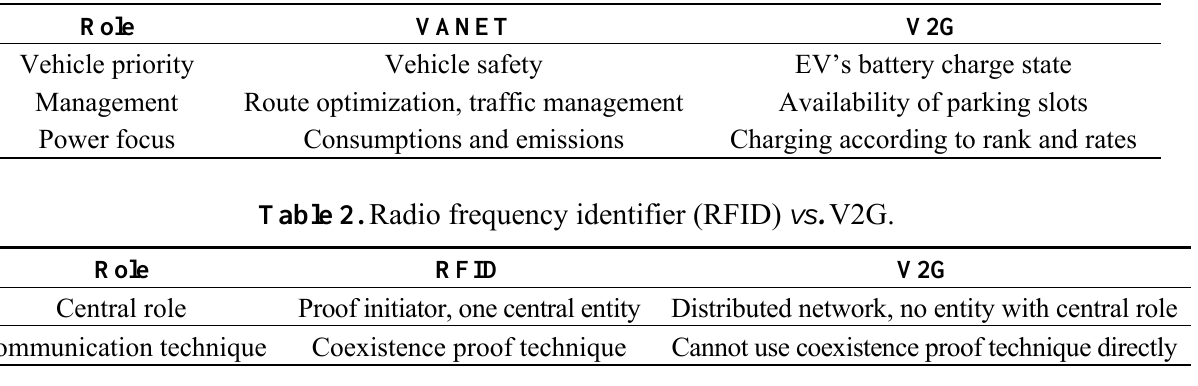
Table 1. Vehicular ad-hoc network (VANET) vs. vehicle-to-grid (V2G). EV: electric vehicle.